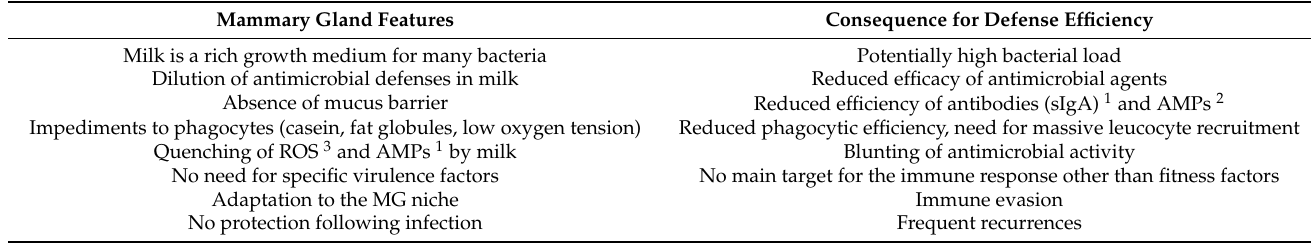
Table 1. Possible reasons for the current mastitis vaccine